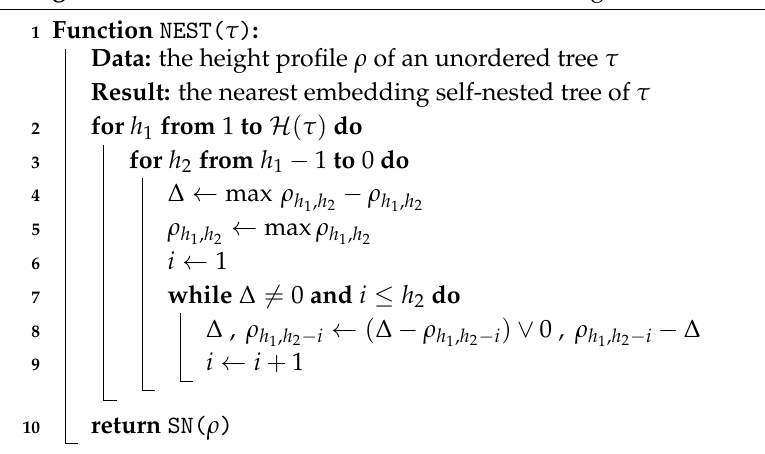
Algorithm 2: Construction of the nearest embedding self-nested